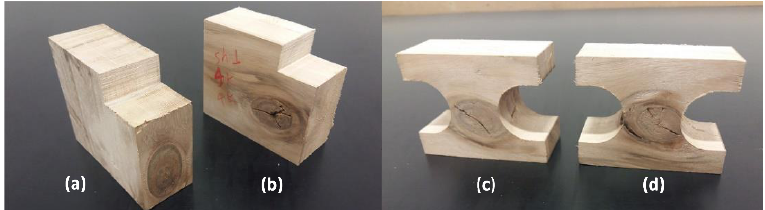
Figure 2. The location of knot in samples prepared for shear strength parallel ( SPA ) test ( a ), perpendicular ( SPE ) test ( b ) and tensile strength perpendicular ( TPE ) test ( c , d